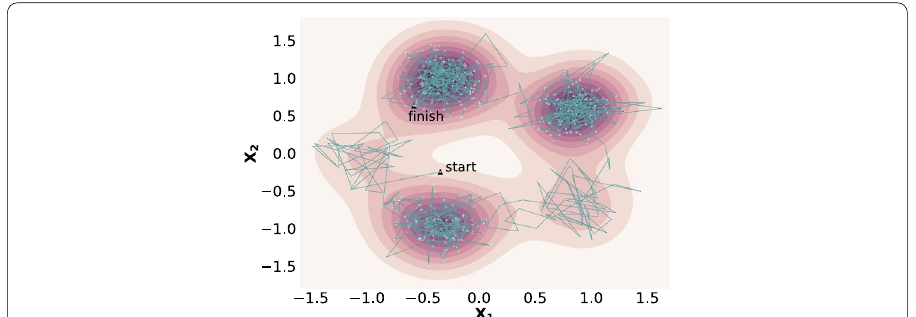
Fig. 3 An example of a trajectory of a particle in the 5-well potential. Points indicate the positions of the particle at time t and blue lines show the movement of the particle from time point t to t +